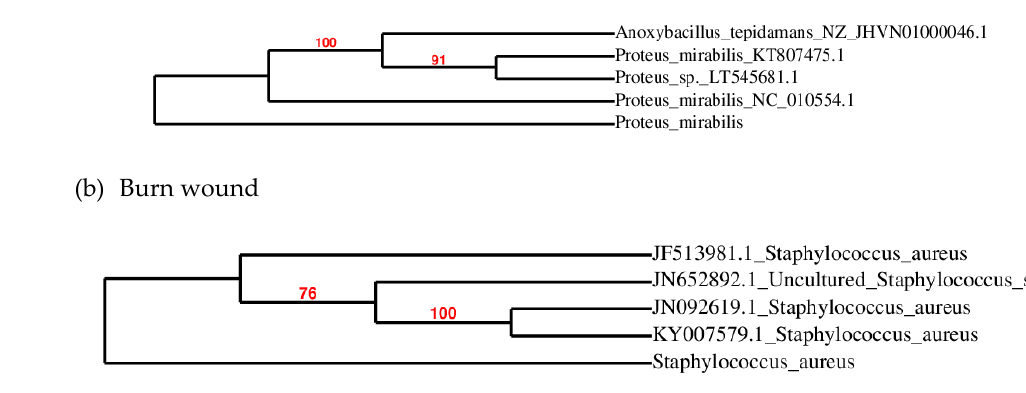
Figure 1. Phylogenetic tree of the bacterial isolate. ( a ) Urinary catheter; ( b ) burn